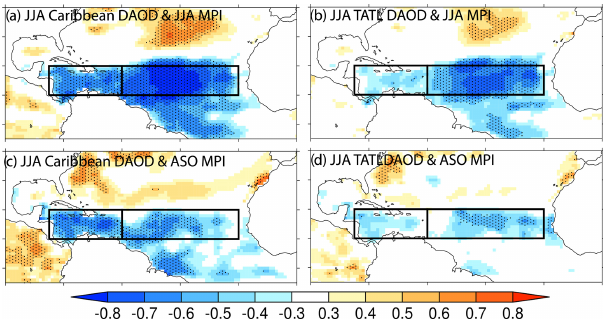
Figure 9. Correlation between (a) MRC JJA regionally averaged DAOD in the Caribbean and JJA maximum potential intensity (MPI), (b) MRC JJA regionally averaged DAOD in the tropical North Atlantic (TATL) and JJA MPI, (c) JJA Caribbean DAOD and ASO MPI, and (d) JJA TATL DAOD and ASO MPI. Correlations over the black dotted areas are statistically significant.